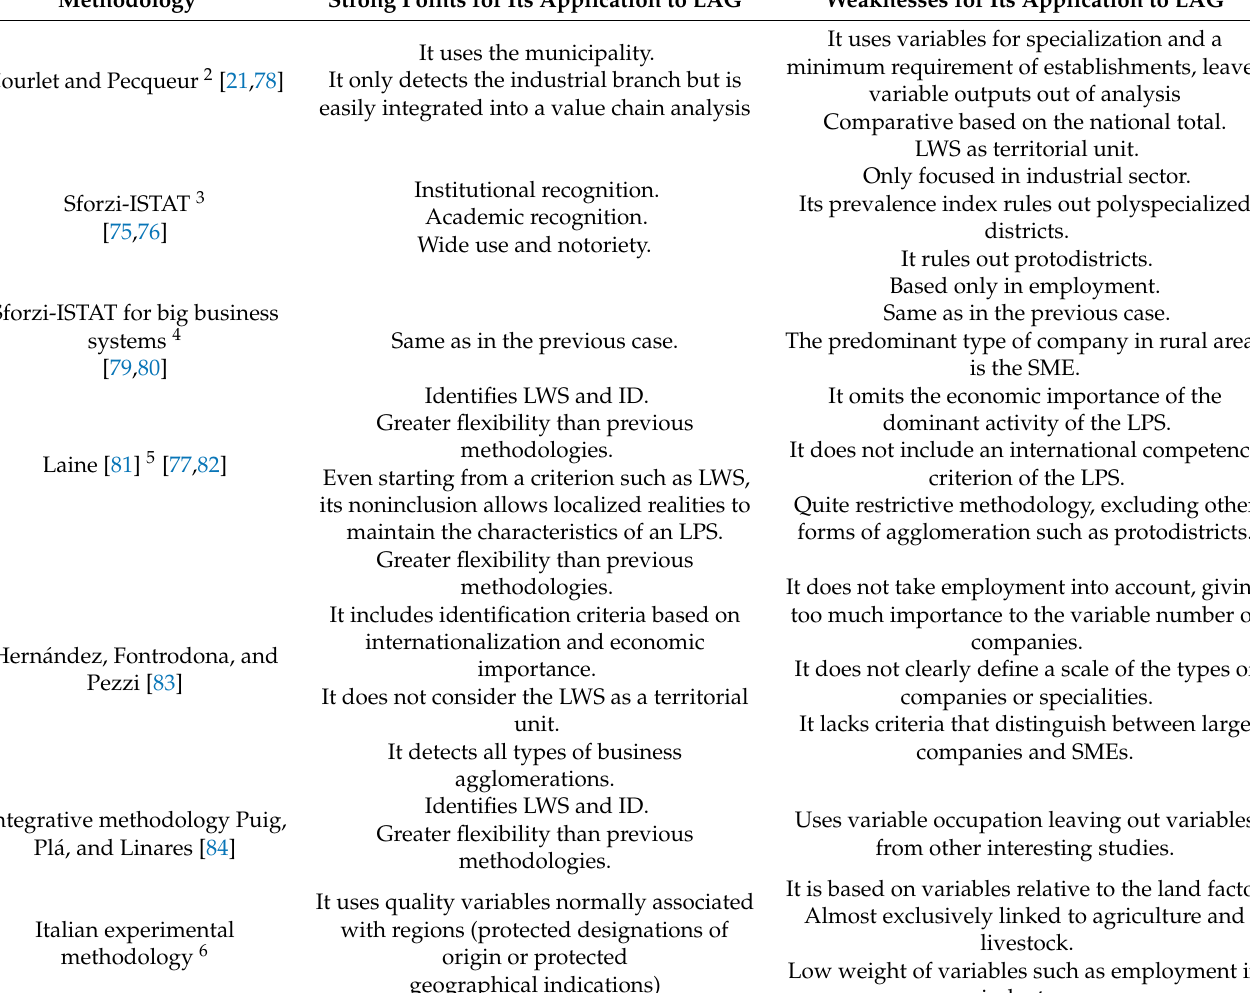
Table 2. Industrial districts (IDs) and/or local productive systems (LPS) identification methodologies and their adaptation to the local action group (LAG) geographical